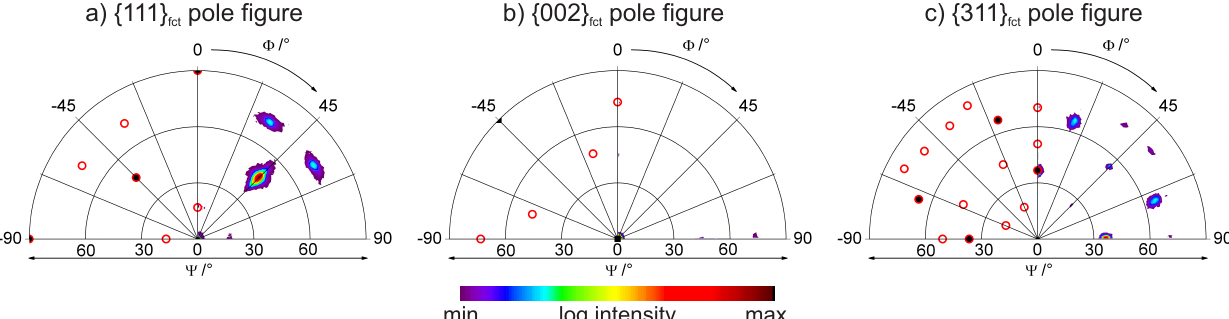
Pd film on Cr buffer (right 70 30 (cid:104) 111 (cid:105) twins (left quadrant) of ( a ) { 111 } bct bct